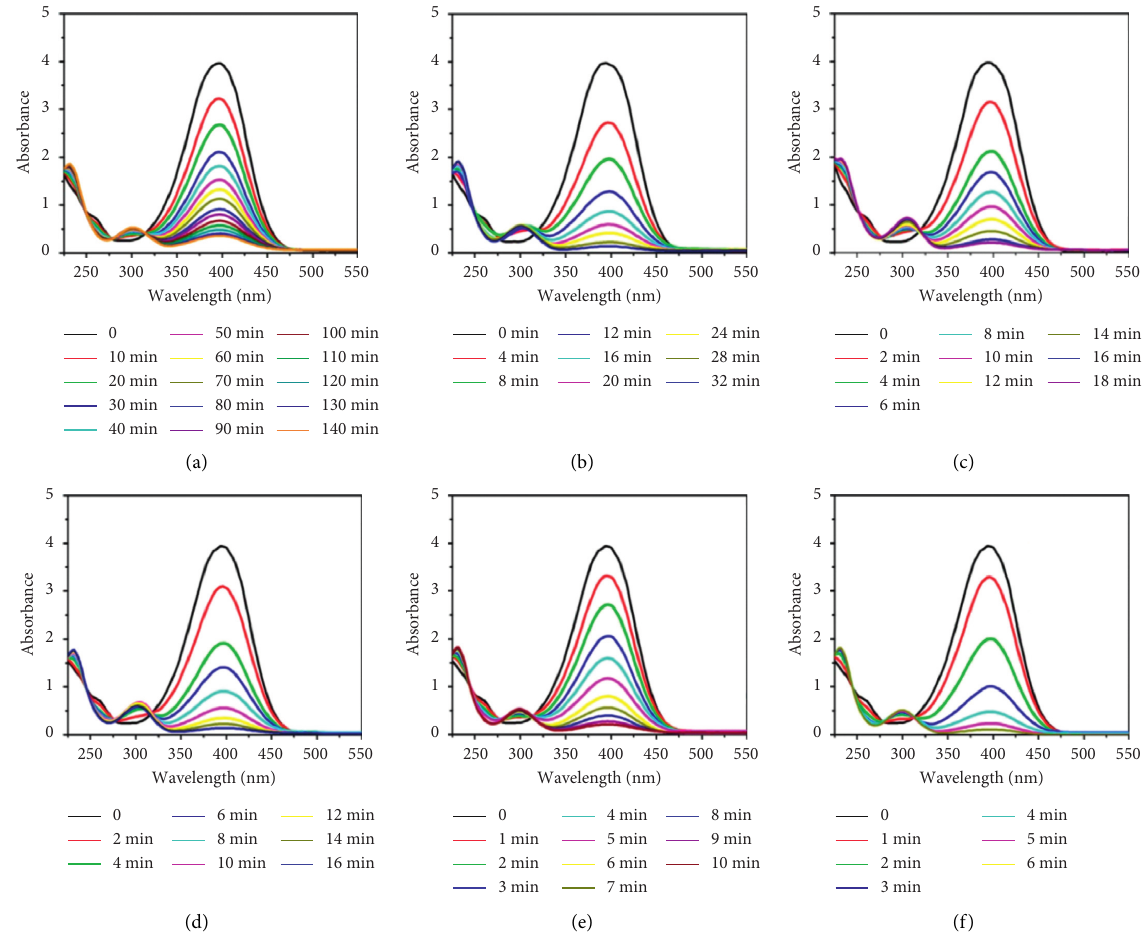
Figure 9: UV absorbance spectrum of catalytic reduction with different Au-based catalysts: (a) Au particle; (b) Ag (c) Ag 83.2 –Au 16.8 ; (d) Ag 66.9 –Au 33.1 ; (e) sample 1; (f) sample